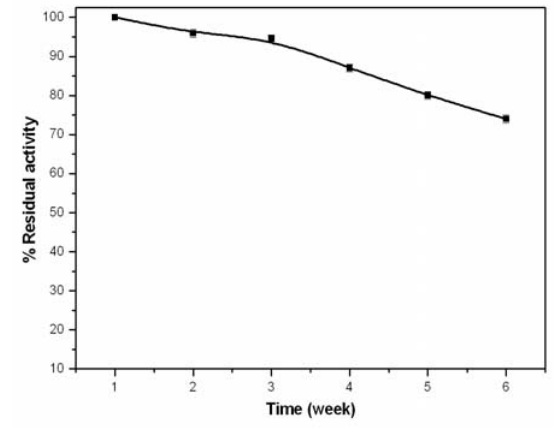
Figure 6. Room temperature activity profile of the stabilized BuChE